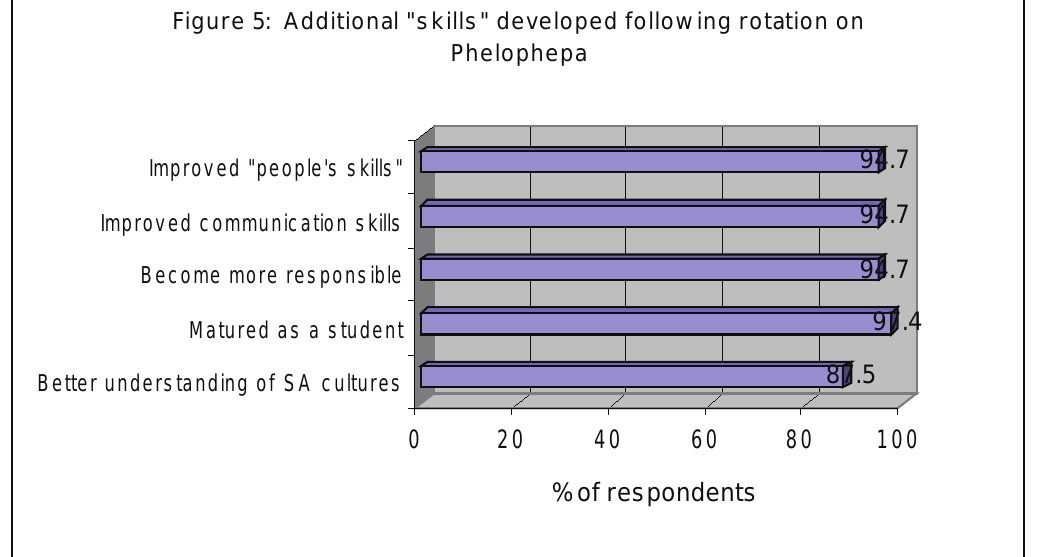
Figure 5: Additional "s k ills " de ve lope d follow ing rotation on Phe lophe